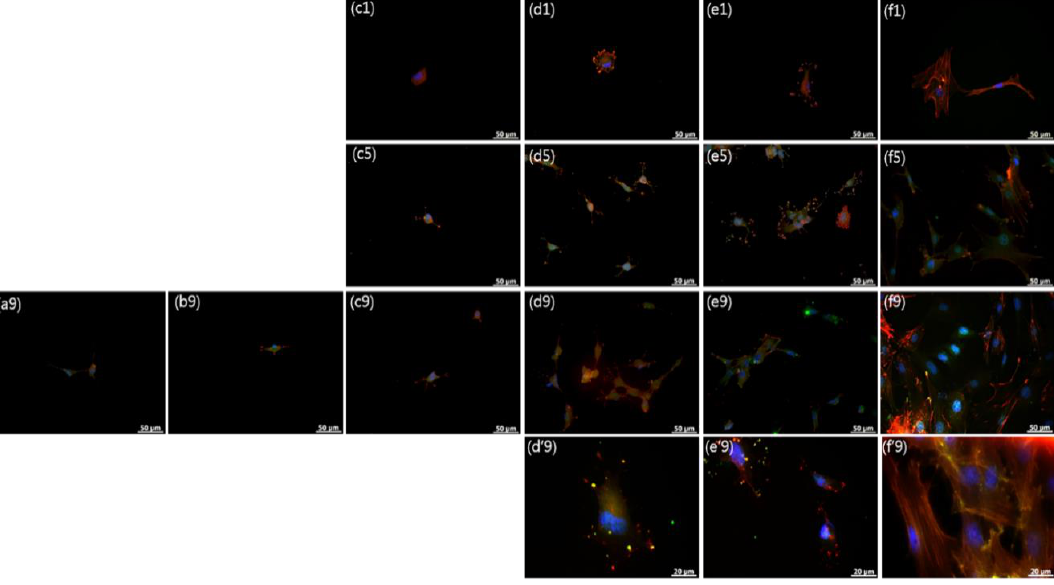
Figure 6. Actin–integrin β1 immunostaining in rMDSCs grown on SN for 1, 5, and 9 days. ( a ) SN-60, ( b ) SN-150, ( c ) SN-300, ( d ) SN-500, ( e ) SN-700, and ( f ) glass. The numbers indicate 1, 5, and 9 d. Blue, DAPI; red, actin; green, integrin β1. Magnification, ×400; scale bar = 50 μm. ( d’9 ), ( e’9 ), and ( f’9 ) are enlarged images (magnification, ×1000). (The enlarged actin–integrin β1 immunostaining images are shown in Supporting Information Figures S4 and S5).